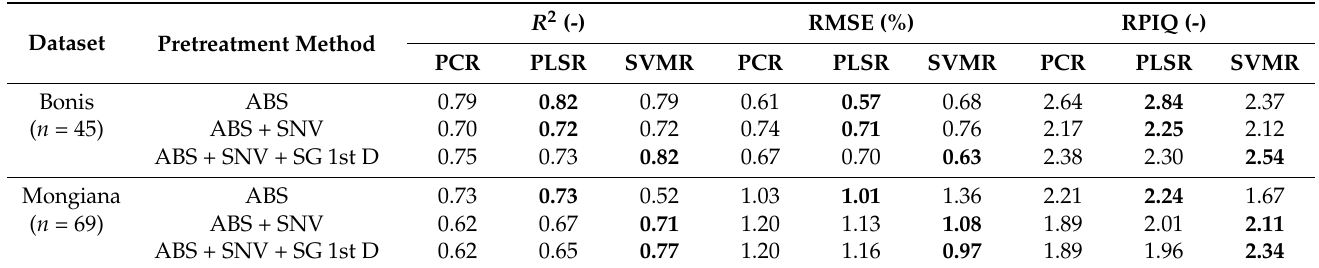
Table 3. Validation results of the models obtained by PCR, PLSR, and SVMR, coupled with different spectroscopic pretreatment techniques for SOC prediction at the two study areas. The best results of the models are highlighted in